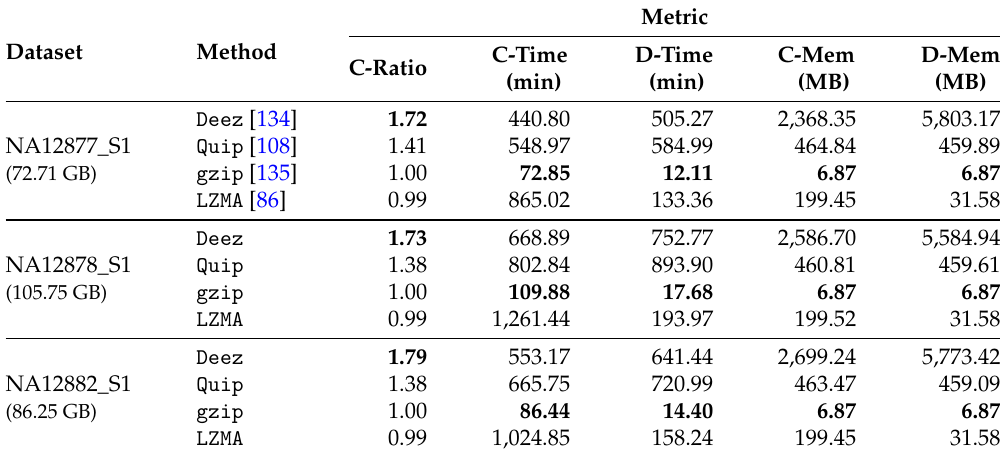
Table 5. Compression results of genomic sequence data for BAM file format.